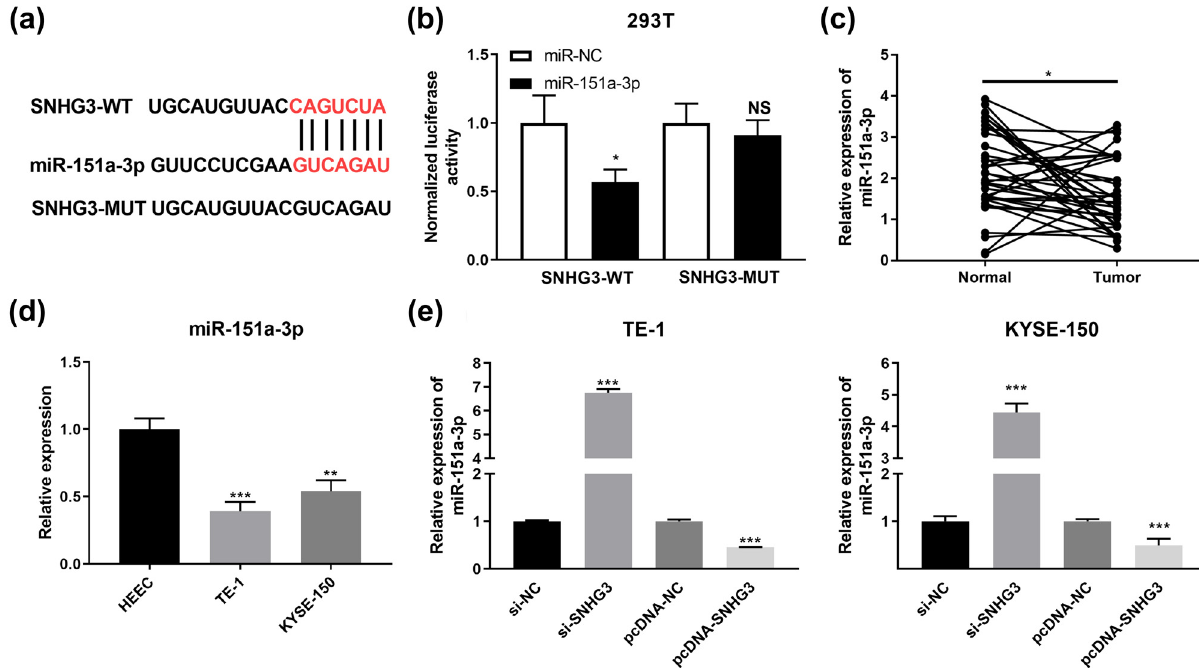
Figure 3: LncRNA SNHG3 directly targeted miR - 151a - 3p in ESCC cells. ( a ) The complementary sequences between SNHG3 and miR - 151a - 3p were exhibited. ( b ) The interaction between SNHG3 and miR - 151a - 3p was estimated by dual luciferase reporter assay. ( c and d ) The expression of miR - 151a - 3p in tissues and cells was determined. ( e ) The expression of miR - 151a - 3p in cells transfected with si - NC/si - SNHG3 or pcDNA - NC/pcDNA - SNHG3. * P < 0.05, ** P < 0.01, *** P <